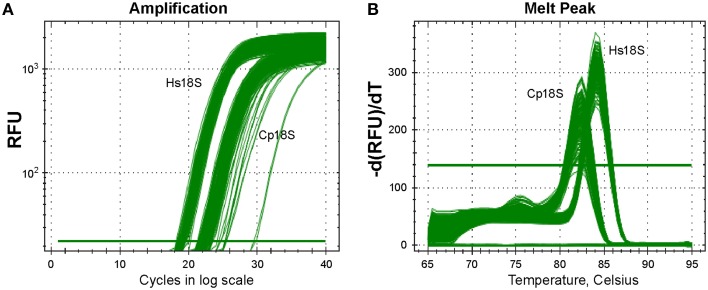
Specific detection of Cp18S and Hs18S rRNA transcripts as demonstrated by amplification curve (A) and melting curve (B) analyses of a representative plate. Lysates of HCT-8 cells grown in 96-well plates and infected with Cryptosporidium parvum for 44 h were used in qRT-PCR reactions in 384-well format.